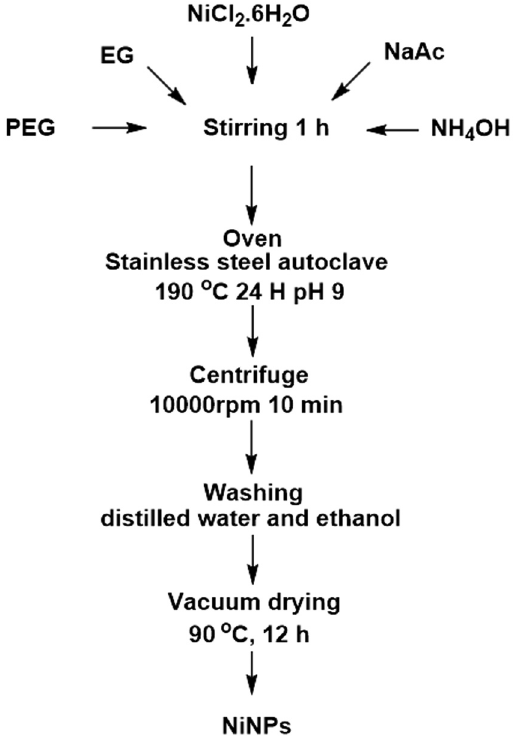
Figure 1: Flow chart of the one - pot solvothermal synthesis of